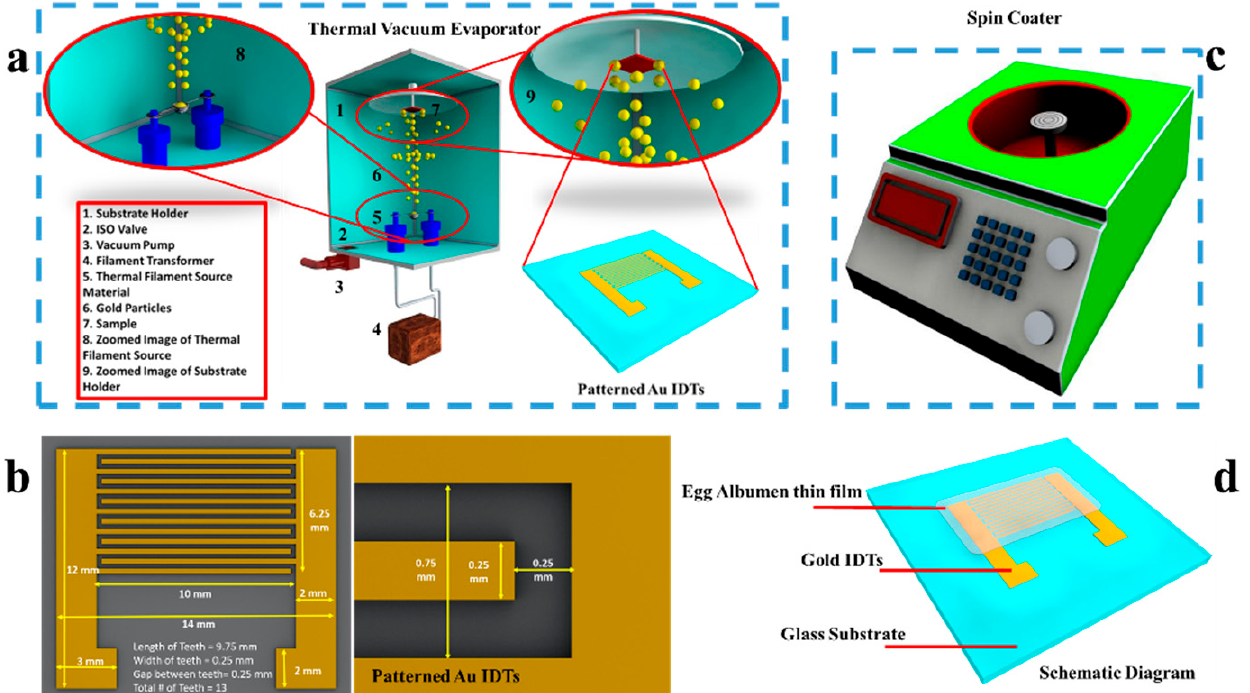
Figure 2. Fabrication of egg white-based humidity sensor. ( a ) Schematic diagram of thermal vacuum evaporation. ( b ) Images of fabricated Au IDTs patterned on transparent glass substrate with labeled dimensions. ( c ) Spin coater for depositing thin film of egg white. ( d ) Schematic diagram of biomaterial-based humidity sensor.